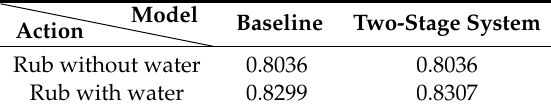
Table 7. Two-stage system: Average Jaccard index.